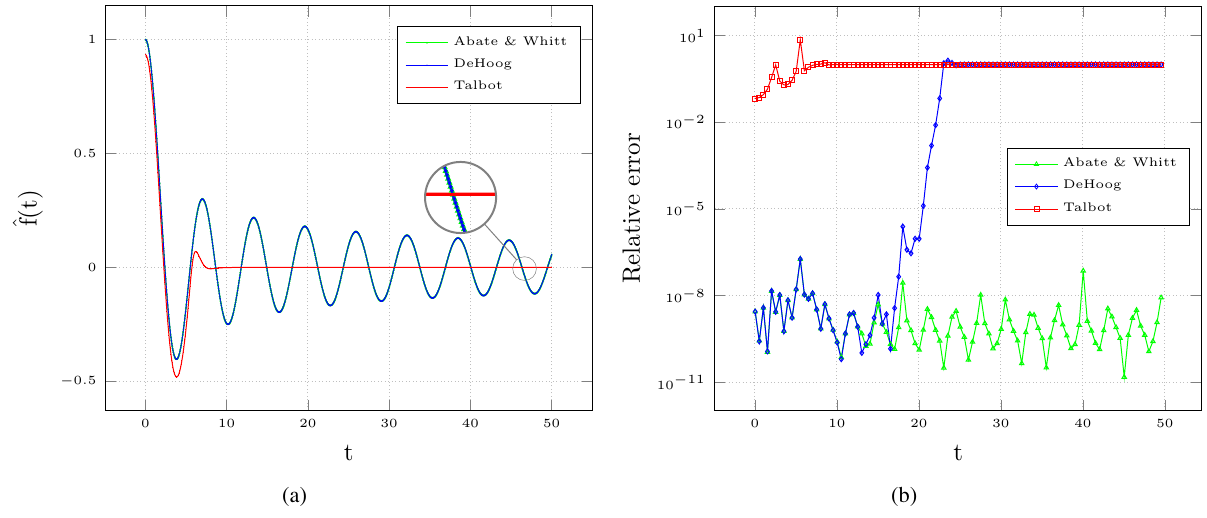
Fig. 4 Plots of numerical inversions ˆ f ( t ) of the Laplace transform (4) (a) and their relative errors (b) for applied methods in interval ( 0 , 50 (cid:105) .